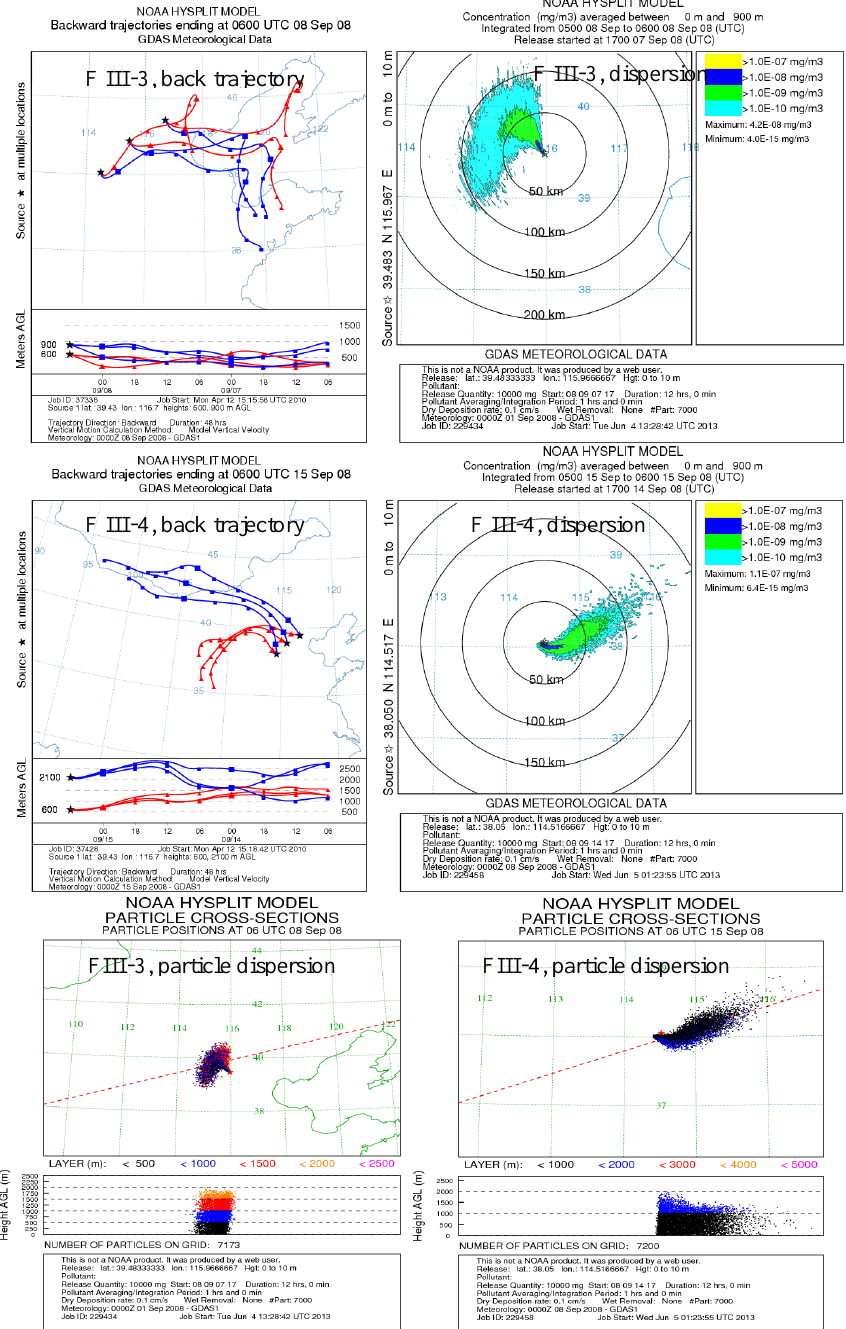
Fig. 6 A 48 h back trajectories and 12 h forecast dispersions for Flight III-3 and Fig. 6. 48h back trajectories and 12h forecast dispersions for flights III-3 and III-4 of G4. 3 September) and shorter, i.e., regional sources, at lower al- titudes (air mass from the south and more local sources on 27 August and 3